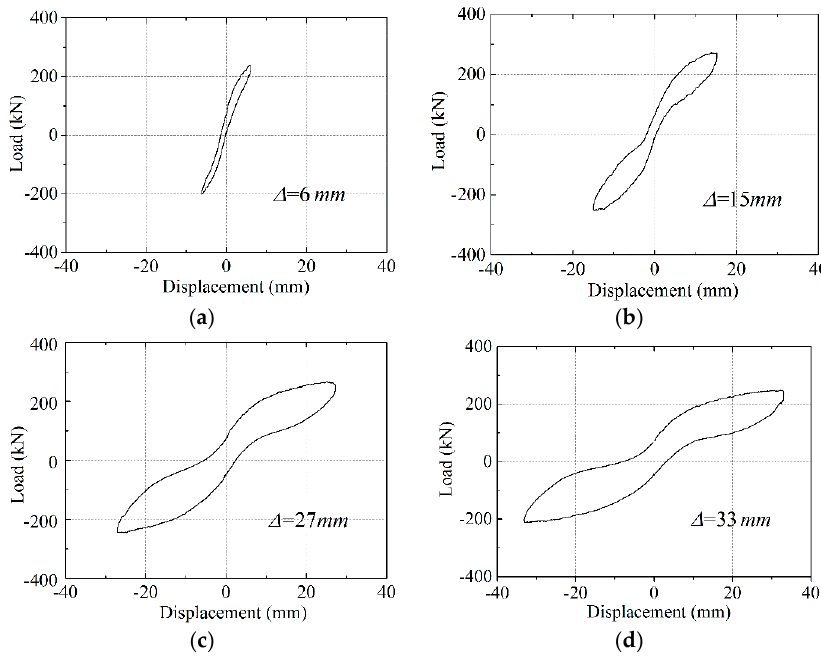
Figure 8. Hysteresis loops of PMW-1: ( a ) Hysteresis loop at yielding; ( b ) hysteresis loop at ultimate load; ( c ) hysteresis loop at about 1% drift; ( d ) hysteresis loop at 15% strength degradation.